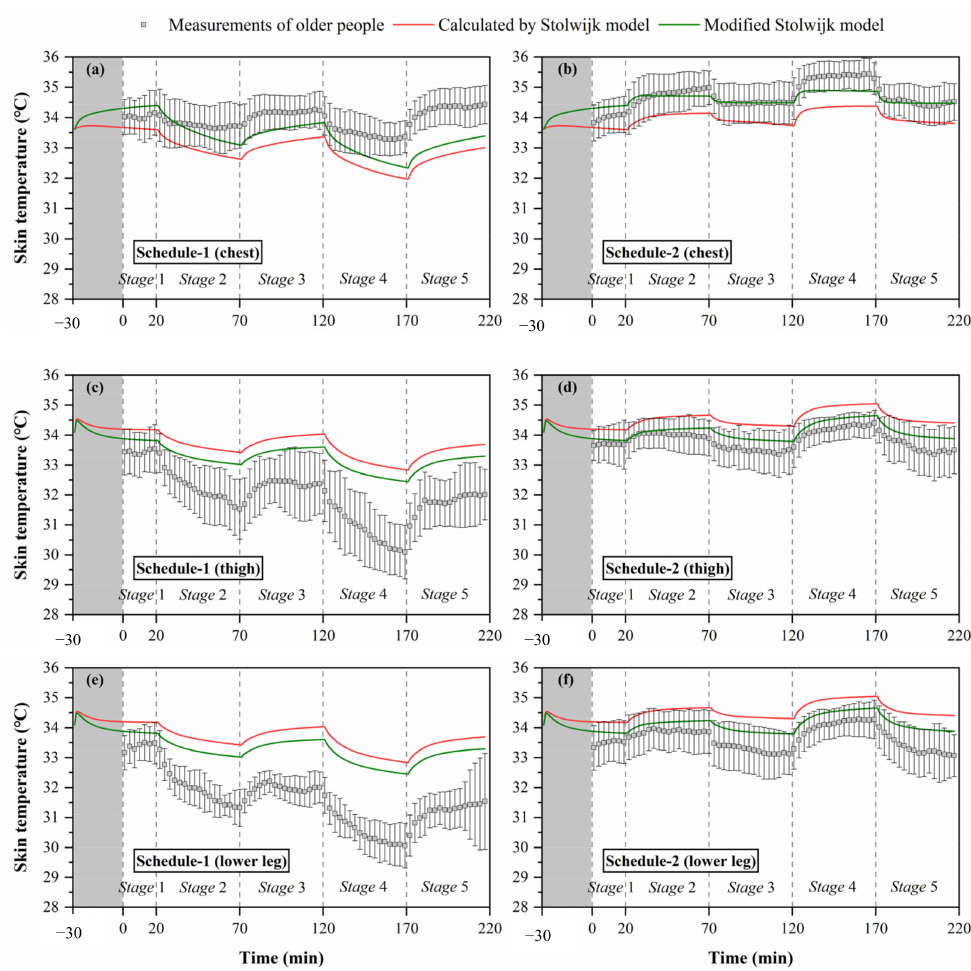
Figure 8. Calculated results of local skin temperatures after modification of the Stolwijk model, ( a ) chest temperature in schedule 1, ( b ) chest temperature in schedule 2, ( c ) thigh temperature in schedule 1, ( d ) thigh temperature in schedule 2, ( e ) lower leg temperature in schedule 1, ( f ) lower leg temperature in schedule 2. Table 9. RMSE ( ◦ C) between and measured skin temperatures and calculated values of modified Stolwijk model. Skin Temperature Schedule